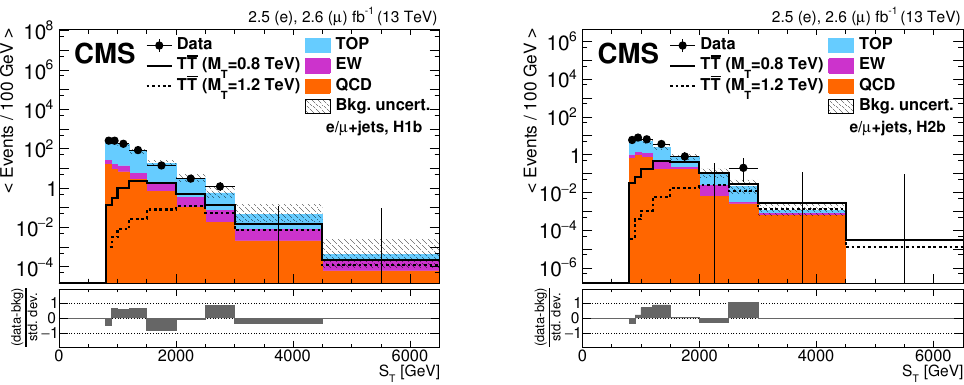
Figure 10 . Distributions of S T in the H1b (left) and H2b (right) categories in the combination of electron and muon channels. The TT signal, shown for T quark masses of 0.8 and 1.2 TeV, is normalized to the theoretical cross section and the singlet benchmark branching fractions are assumed. The uncertainty in the background includes the statistical and systematic uncertainties described in section